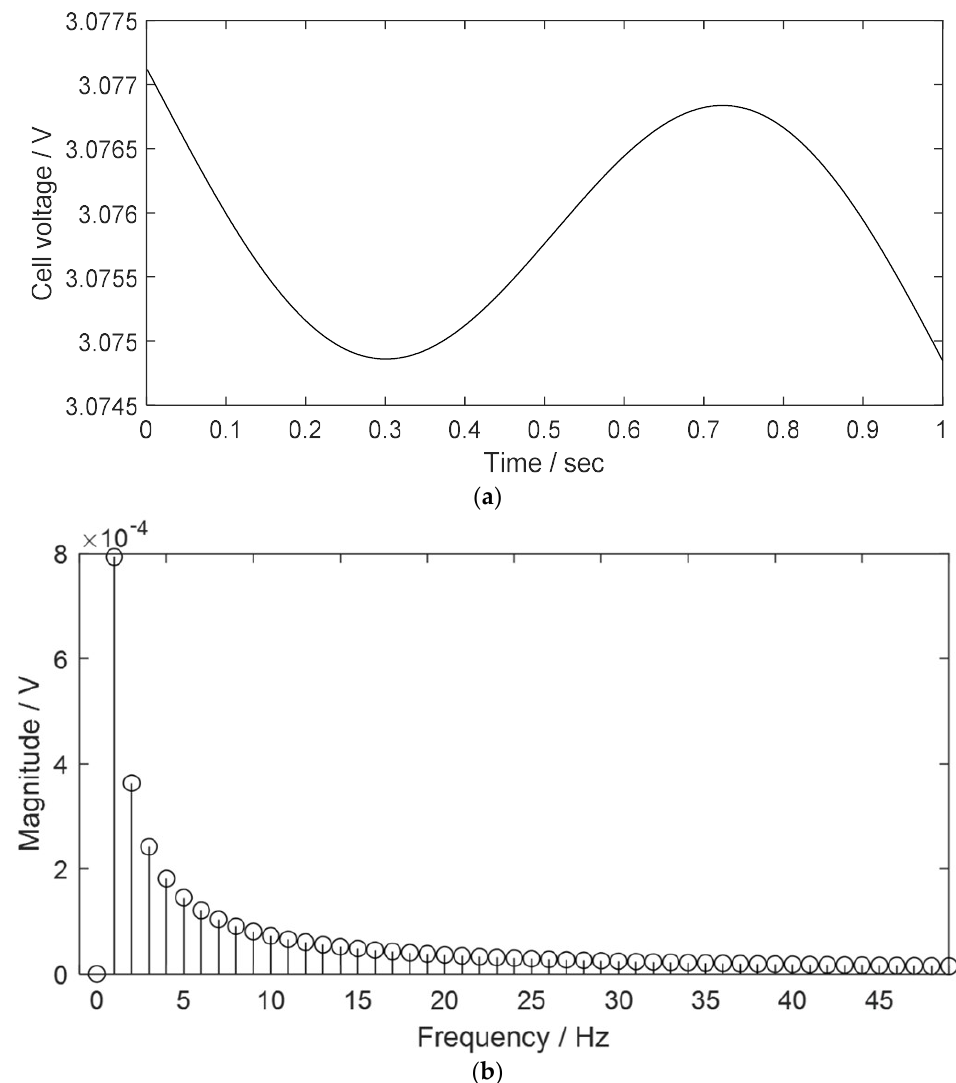
Figure 4. Voltage response simulated for 1 s at a cell SoC of 2% ( a ) in a time domain and ( b ) in a frequency domain.